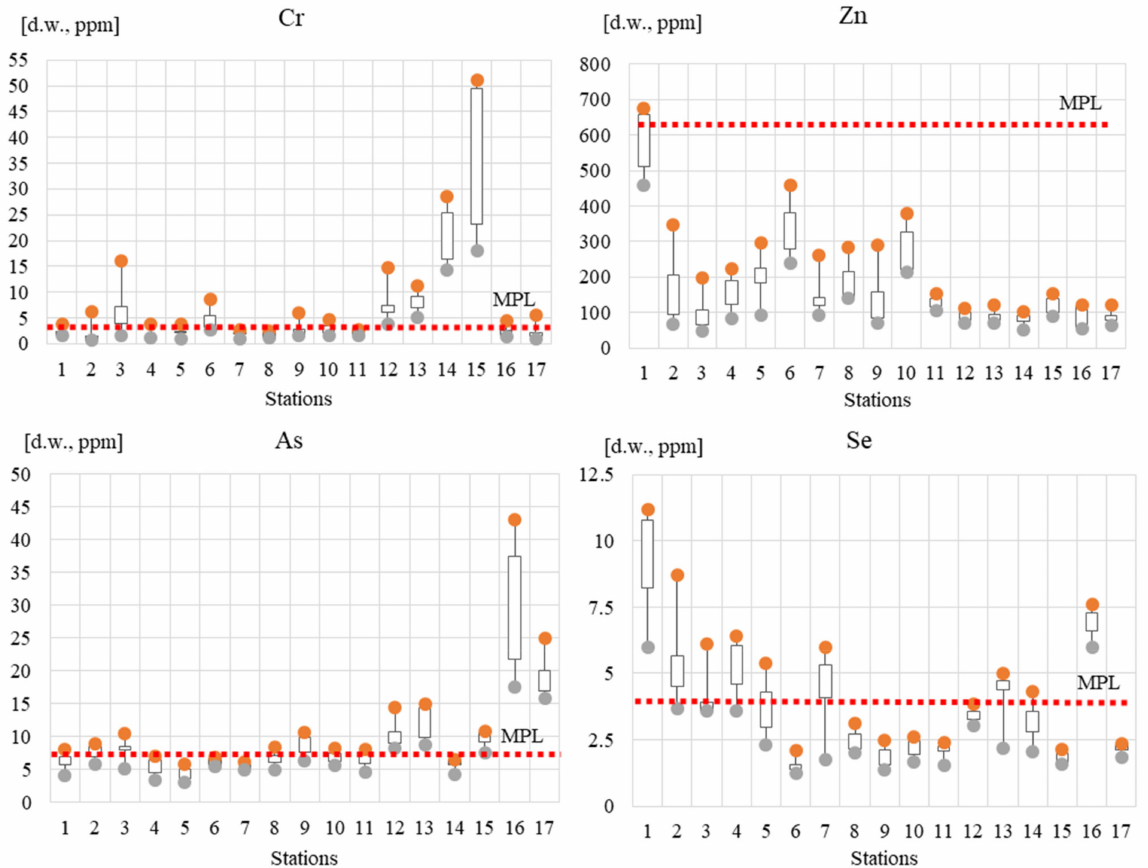
Figure 2. Levels of concentrations in dry weight of soft tissues and maximum permissible levels. The point markers–min and max, boxes–interquartile range. Red dotted line corresponds to MPLs.